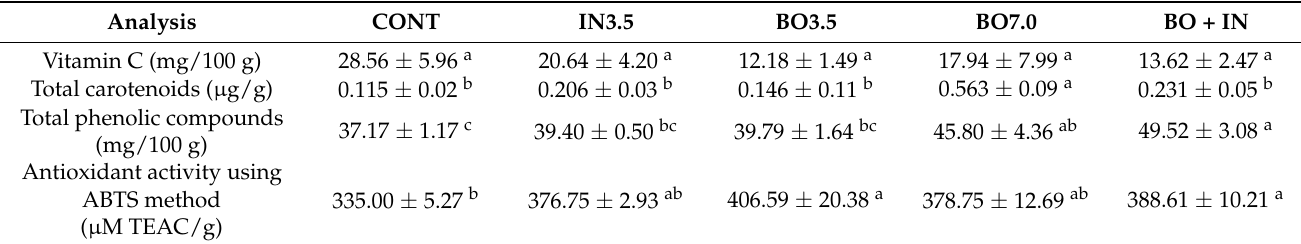
Table 5. Chemical composition of soymilk fermented with kefir and supplemented with inulin and bocai ú va powder-pulp.